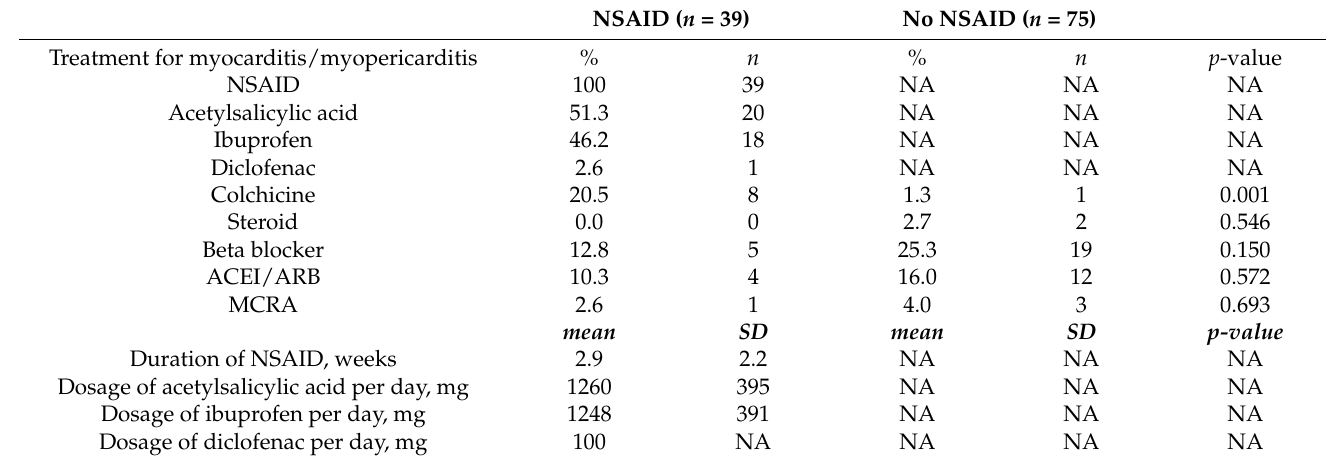
Duration of NSAID, weeks NA NA NA Dosage of acetylsalicylic acid per day, mg 1260 395 NA NA NA Dosage of ibuprofen per day, mg 1248 391 NA NA NA Dosage of diclofenac per day, mg 100 NA NA NA